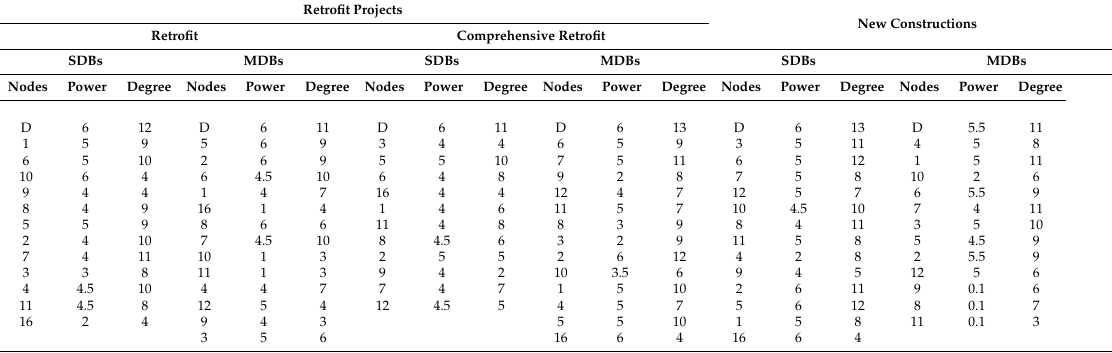
Table A9. Numerical output stakeholder networks classified according to building typologies and project types in the Netherlands (NL).